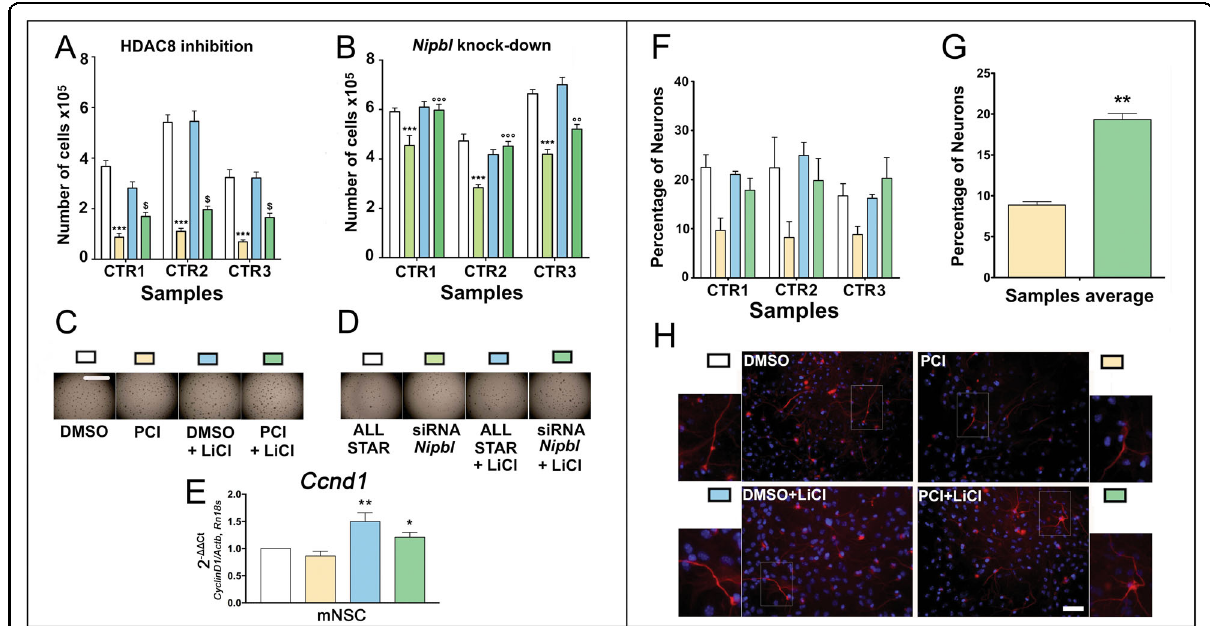
Fig. 3 Lithium rescues proliferation and differentiation capabilities in CdLS mouse NSCs through WNT activation. A Analysis of the effects of PCI34051 and lithium exposure on the proliferation capabilities of the NSCs. White: NSCs treated with DMSO; yellow: NSCs treated with PCI34051; light blue: NSCs treated with DMSO + LiCl; dark green: NSCs treated with PCI34051 and LiCl. *** p < 0.001; $ p < 0.05; * DMSO vs PCI34051; $ PCI34051 vs PCI34051 + LiCl. B Analysis of the effects of Nipbl knockdown and lithium exposure on the proliferation capabilities of the NSCs. White: NSCs treated with AllStar; light green: NSCs treated with siRNA against Nipbl ; light blue: NSCs treated with AllStar and LiCl; dark green: NSCs treated with siRNA against Nipbl and LiCl. *** and °°° p < 0.001; * AllStar vs siRNA against Nipbl ; ° siRNA against Nipbl vs siRNA against Nipbl + LiCl. C Representative pictures of the neurospheres growing in the well during various treatments as in panel ( A ). Scale bar: 2 mm. D Representative pictures of the neurospheres growing in the well during various treatments as in panel ( B ). E Analysis of the effects of PCI34051 and lithium exposure on the gene expression of Ccnd1 in the NSCs. White: NSCs treated with DMSO; yellow: NSCs treated with PCI34051; light blue: NSCs treated with DMSO + LiCl; dark green: NSCs treated with PCI34051 and LiCl. ** p < 0.01; * p < 0.05; ** DMSO + LiCl vs PCI34051; * PCI34051 + LiCl vs PCI34051. F Analysis of the effects of PCI34051 and lithium on the differentiation capabilities of the NSCs. Cells were immunostained for neuron and nuclei detection. White: NSCs treated with DMSO; yellow: NSCs treated with PCI34051; light blue: NSCs treated with LiCl; dark green: NSCs treated with PCI34051 and LiCl. G Comparison of the effects of PCI34051 and PCI34051 + LiCl of NSCs differentiation. ** p < 0.01; * PCI34051 vs PCI34051 + LiCl. H Representative staining of the differentiated NSCs. Differentiated neurons were labeled with β -tubulin III antibody (red) and nuclei were labeled with DAPI (blue). Scale bar: